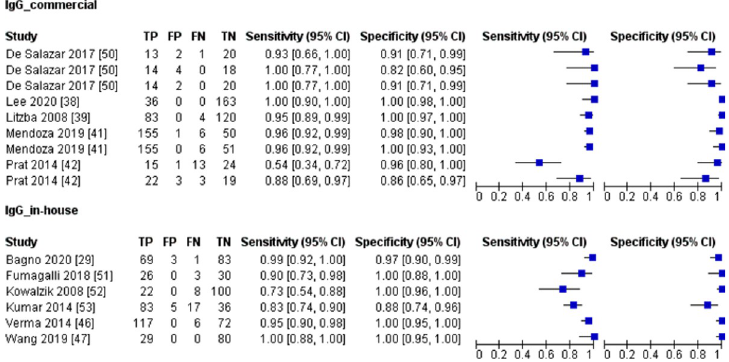
Fig 7. Forest plot for IgG detection test based on in-house developed and commercial test; CI, confidence interval; TP, true positive; FP, false positive; FN, false negative; TN, true